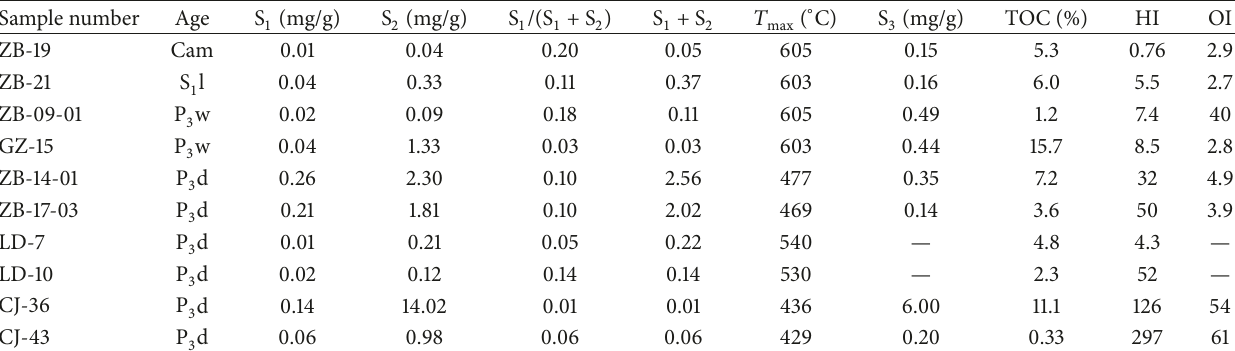
Table 2: Rock Eval pyrolysis data of the potential source rocks.